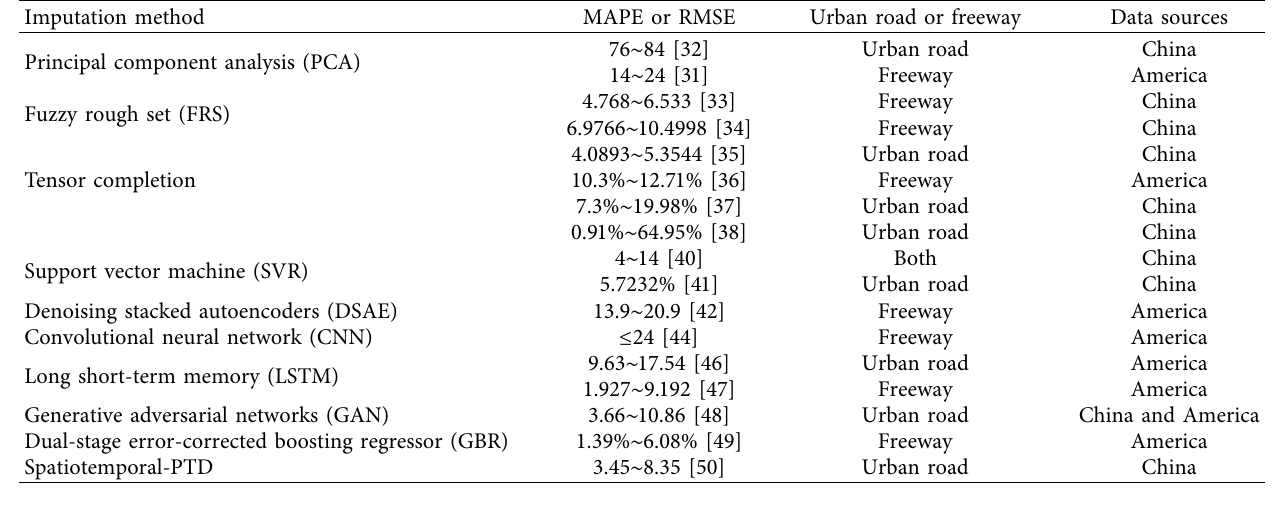
Table 1: Measurement